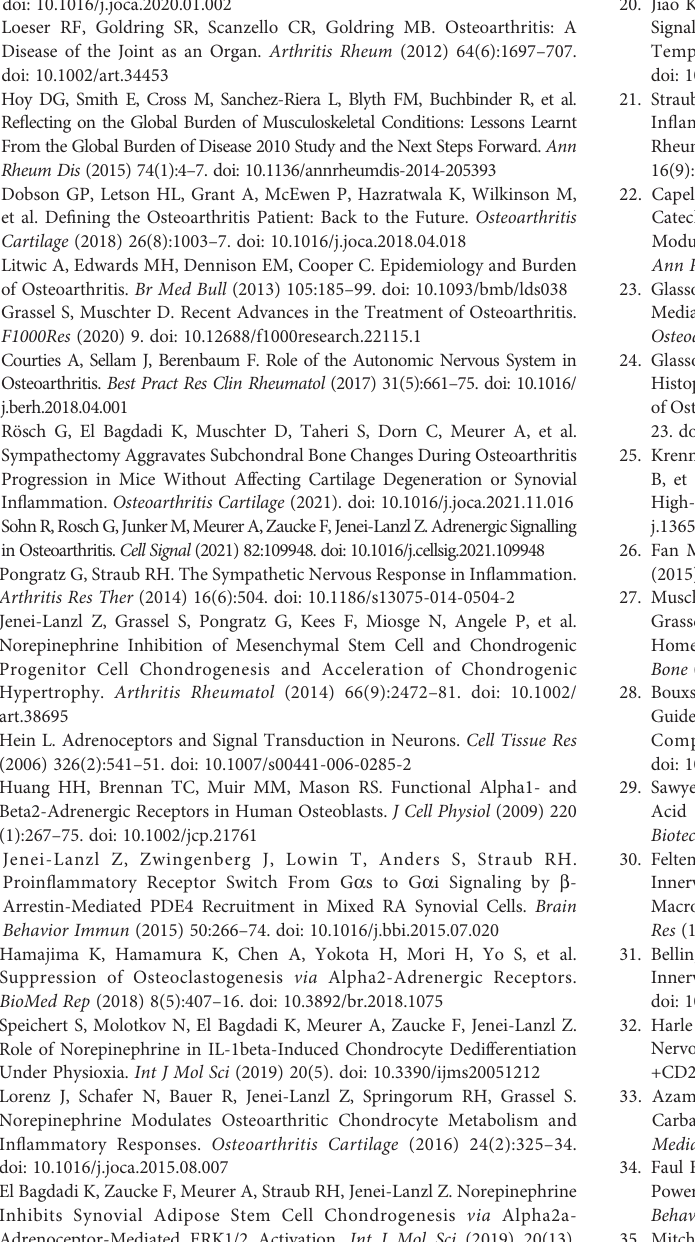
Supplementary Figure 5 | Body weight, body length at the same time points in healthy non-operated WT and Adrb2 -/- mice like 2, 4, 8 and 12 weeks after DMM or